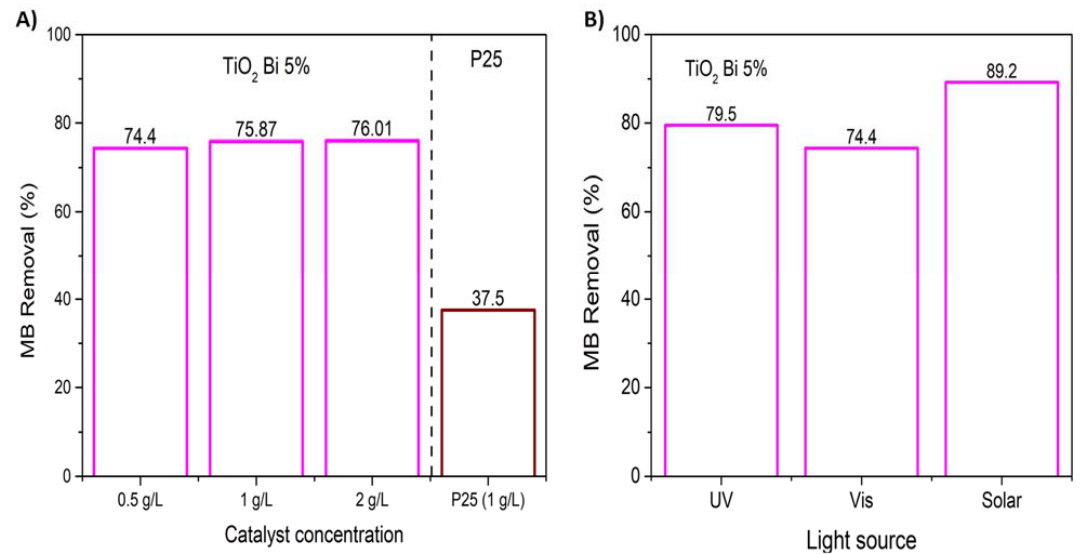
Figure 12. MB photodegradation as a function of TiO 2 Bi 5% photocatalyst concentration under visible light ( A ); MB photodegradation with P25 is included. Effect of the type of irradiation on MB